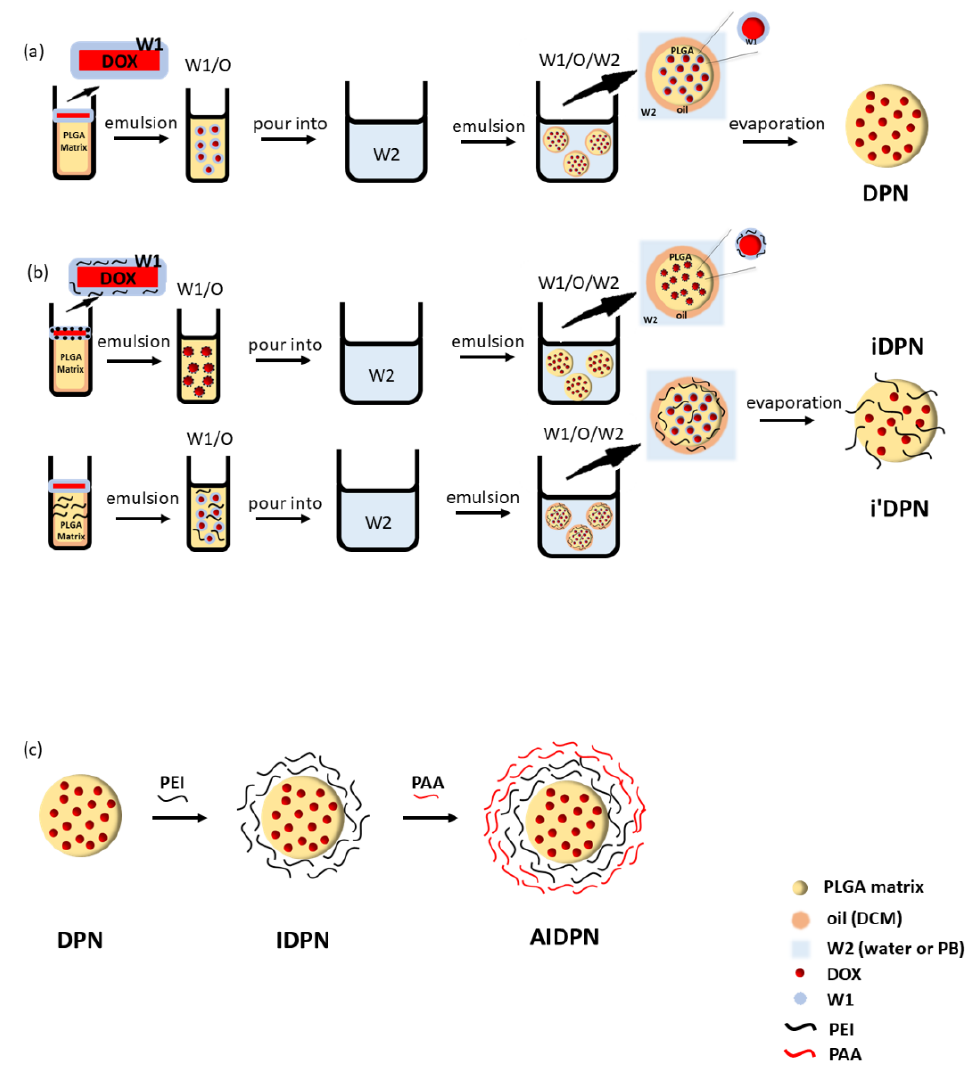
Figure 1. Schematic representation of ( a ) DPN (DOX-loaded PLGA nanoparticle), ( b ) iDPN (PEI was added in W1 during the incorporation process), i’DPN (PEI was added in O during the incorporation process), ( c ) IDPN (PEI-DPN), and AIDPN (PAA-PEI-DPN). Abbreviations: DCM, dichloromethane; DOX, Doxorubicin hydrochloride; W1, 0.5% DOX aqueous solution; W2, outer water, which was water or PB (phosphate buffer; pH 8); PEI, polyethylenimine; PAA, poly(acrylic acid).